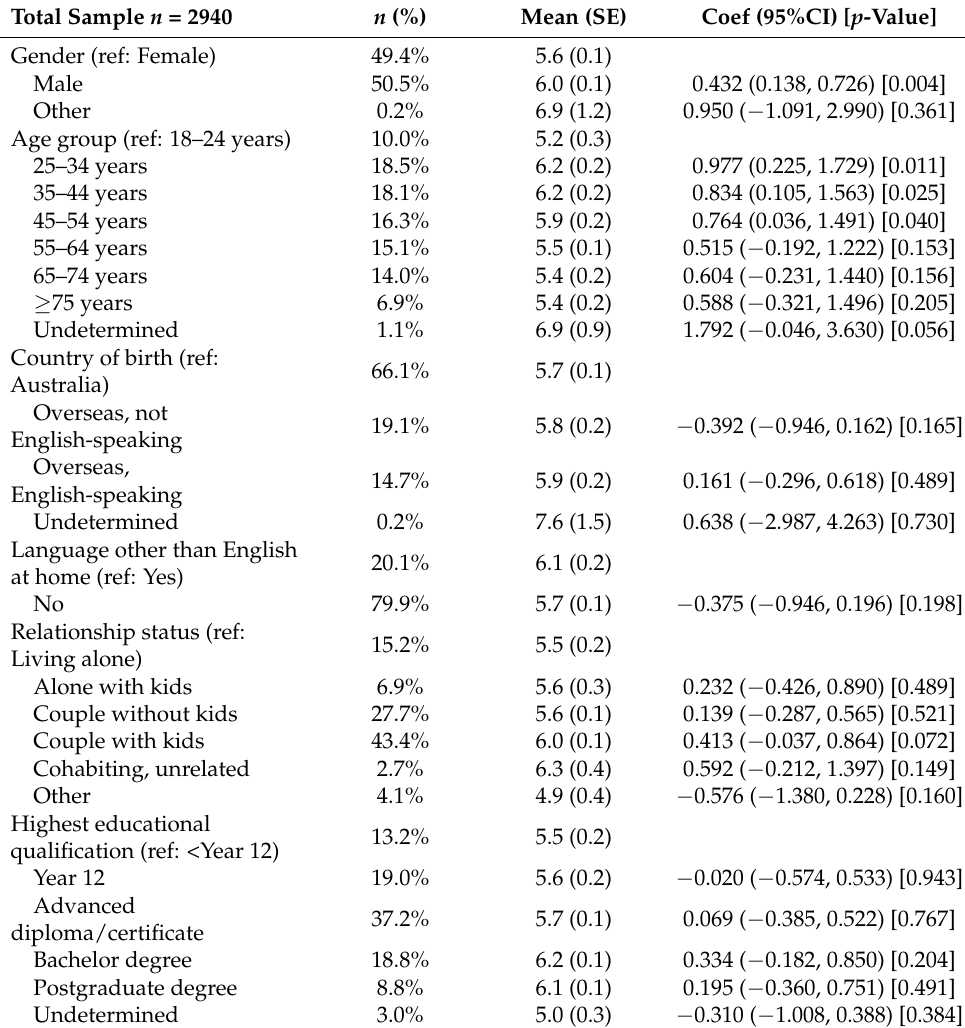
Table 4. Sample description, mean quality of preferred nearby natural setting, and adjusted differ- ences, weighted for national